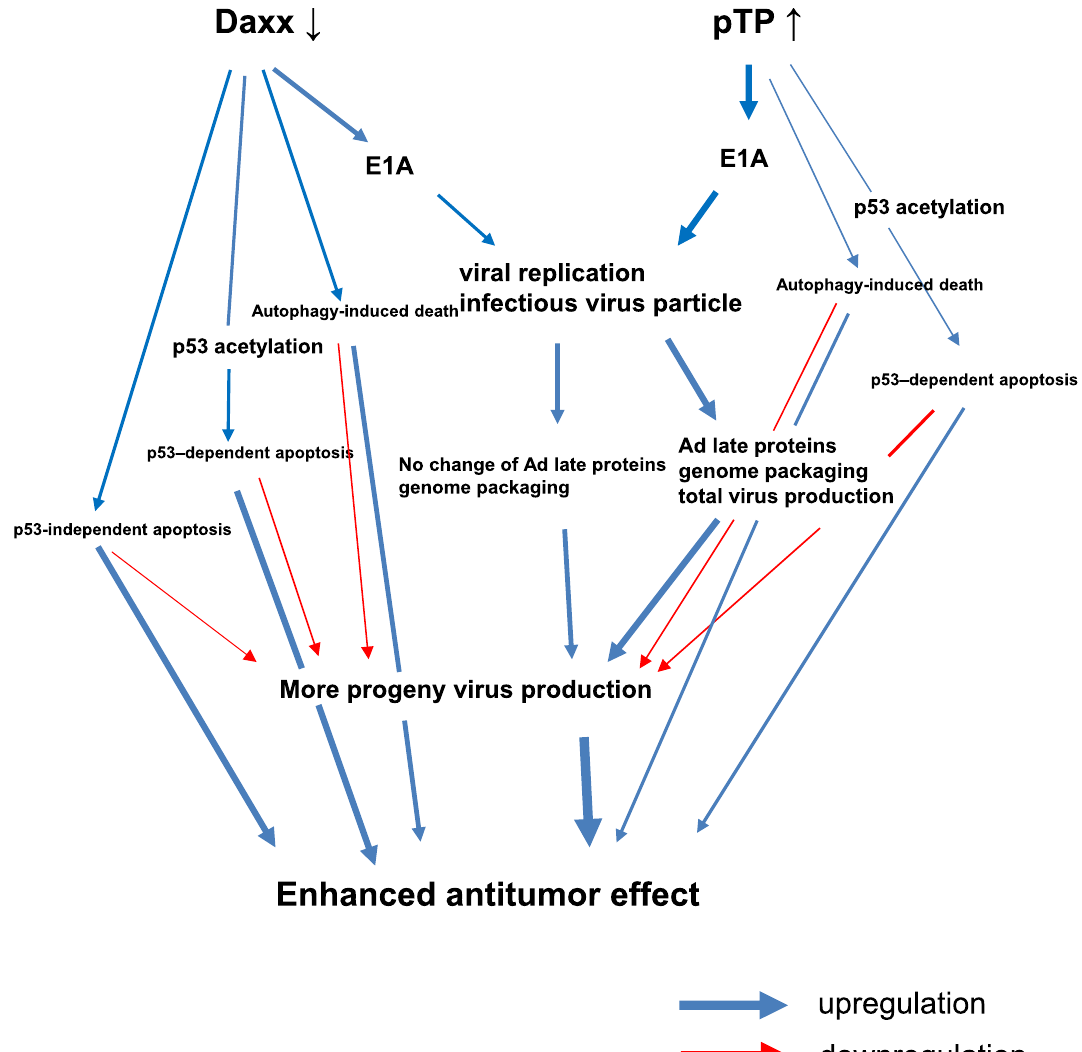
Figure 6. Schematic diagram of enhanced viral production and anti-tumoral effect by a combination of Daxx downregulation, and pTP upregulation, in E1B55K/19K deleted oncolytic adenovirus. pTP upregulation greatly increased viral production, while Daxx downregulation increased mainly infectivity, but not total virus particles. Additionally, Daxx downregulation induced stronger apoptotic cell death than pTP expression did in tumor cells with wild type p53, resulting in an enhanced anti-tumoral effect. This suggests that the combination of both Daxx downregulation and pTP upregulation in oncolytic adenovirus therapy could be an ideal cooperative